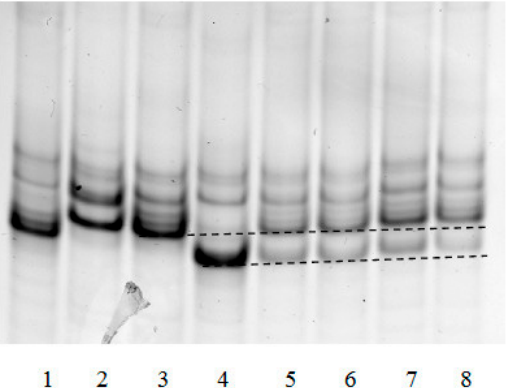
Figure 4. Separation in non-denaturing polyacrylamide gel of the products synthesized by